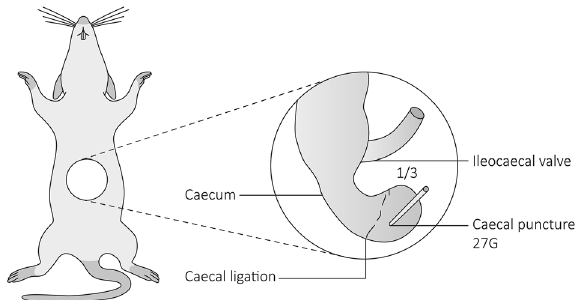
Figure 1. Experimental design to induce advanced appendicitis. After median laparotomy, the caecum identified. The caecum was ligated at the last third which includes the caecal patch (the murine equivalent